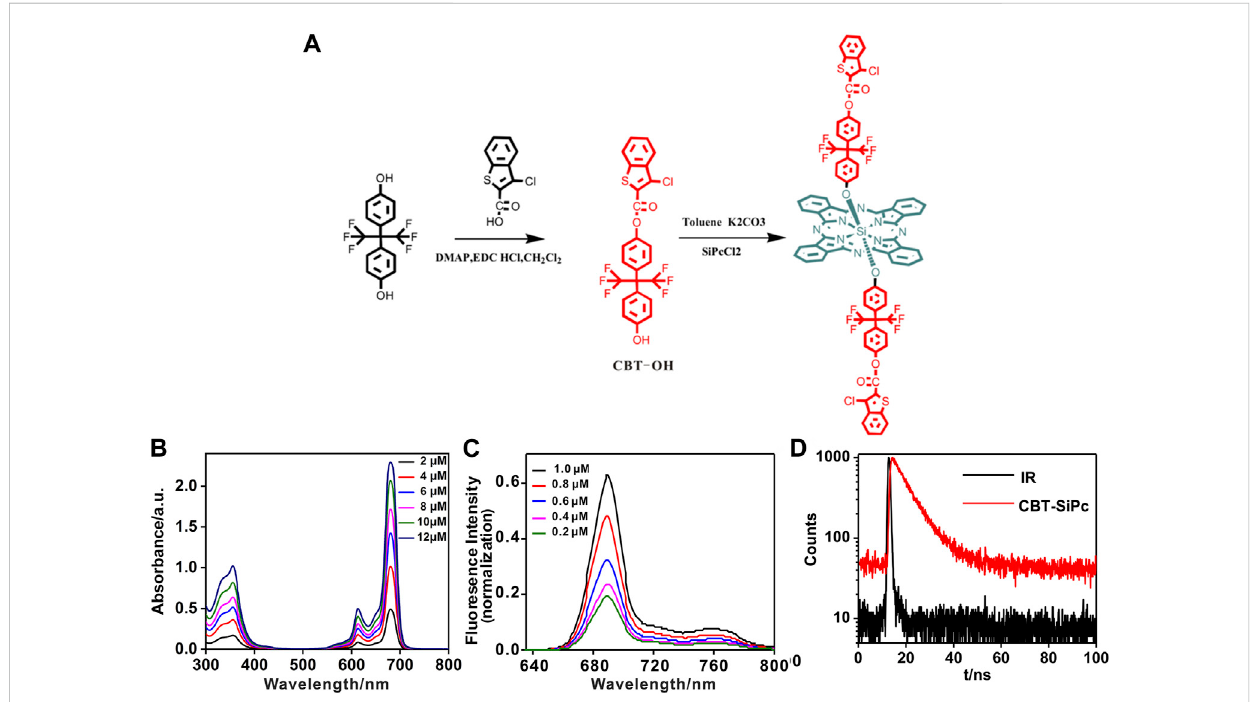
FIGURE 1 (A) Synthesisschemeforchlorophenylthiophenesilicon(IV)phthalocyanine(CBT-SiPc). (B) UV/VisspectrafordifferentconcentrationsofCBT-SiPc. (C) Fluorescence spectra of different concentrations of CBT-SiPc ( λ ex = 615 nm). (D) Fluorescence decay curves of CBT-SiPc in DMF. ( λ ex = 405 nm, C = 10